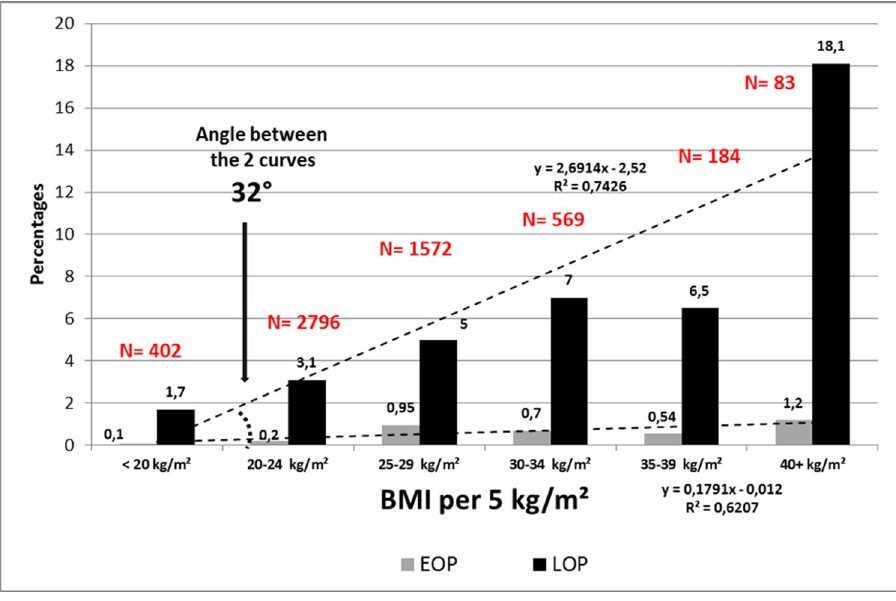
Fig 2. SCOPE study. Prevalence (%) of EOP and LOP per categories of BMI,. 278 preeclampsia 28 EOP (10,0%), 250 LOP (34 weeks +).